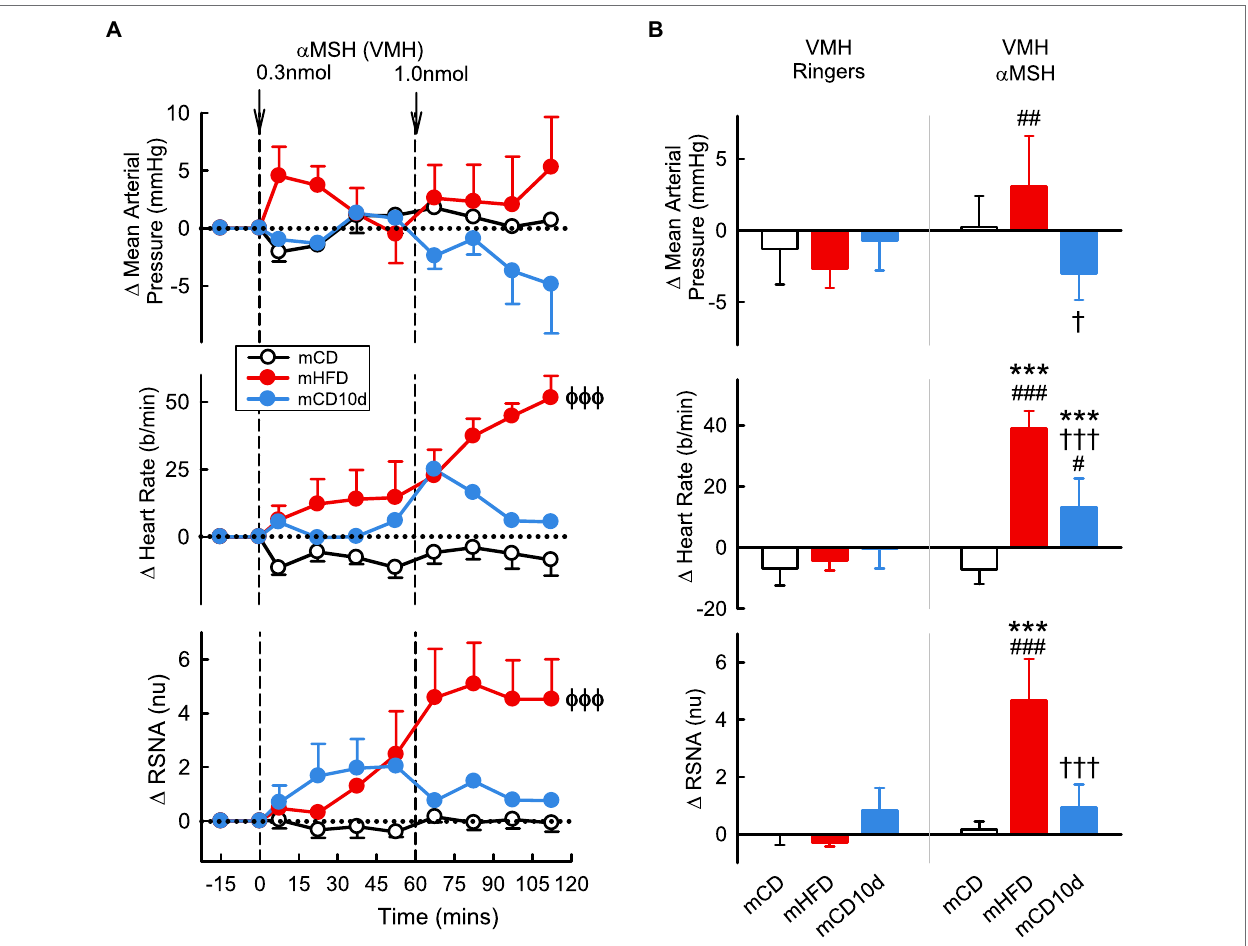
FIGURE 7 | Effects of α MSH injected in the VMH. (A) Average changes in MAP, heart rate, and RSNA (normalized units) from control in each group after VMH injection of α MSH (0.3, 1.0 nmol, shown at dashed lines) in mCD (white, n = 8), mHFD (red, n = 7), and mCD10d (blue, n = 4) rabbits. Data are mean difference ± SED. ϕϕϕ p < 0.001 for average effect of α MSH. (B) Changes from control after administration of vehicle Ringer’s and α MSH, averaged over the second dose, given into the VMH in mCD, mHFD, and mCD10d rabbits. Data are mean difference ± SED from the control period of each treatment group. *** p < 0.001 for comparison to mCD, † p < 0.05 and ††† p < 0.001 for mHFD vs. mCD10d; and ## p < 0.01 and ### p < 0.001 for effect of α MSH vs.